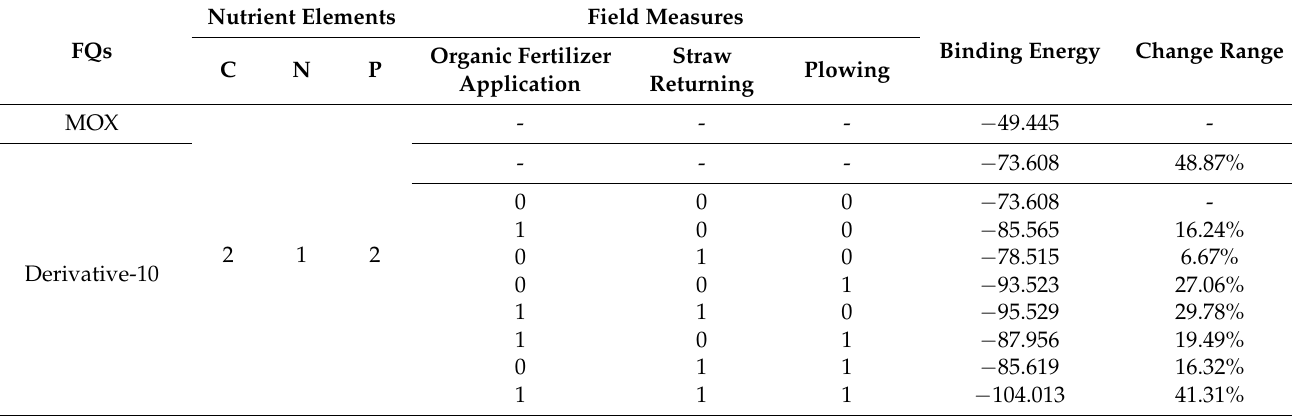
Table 7. Effects of Derivative-10 on the expression of bacterial drug resistance under different field